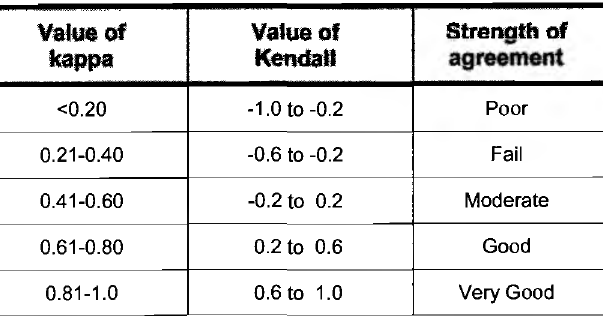
Table 1: Values representing strength of agreement for Kendall's W score.